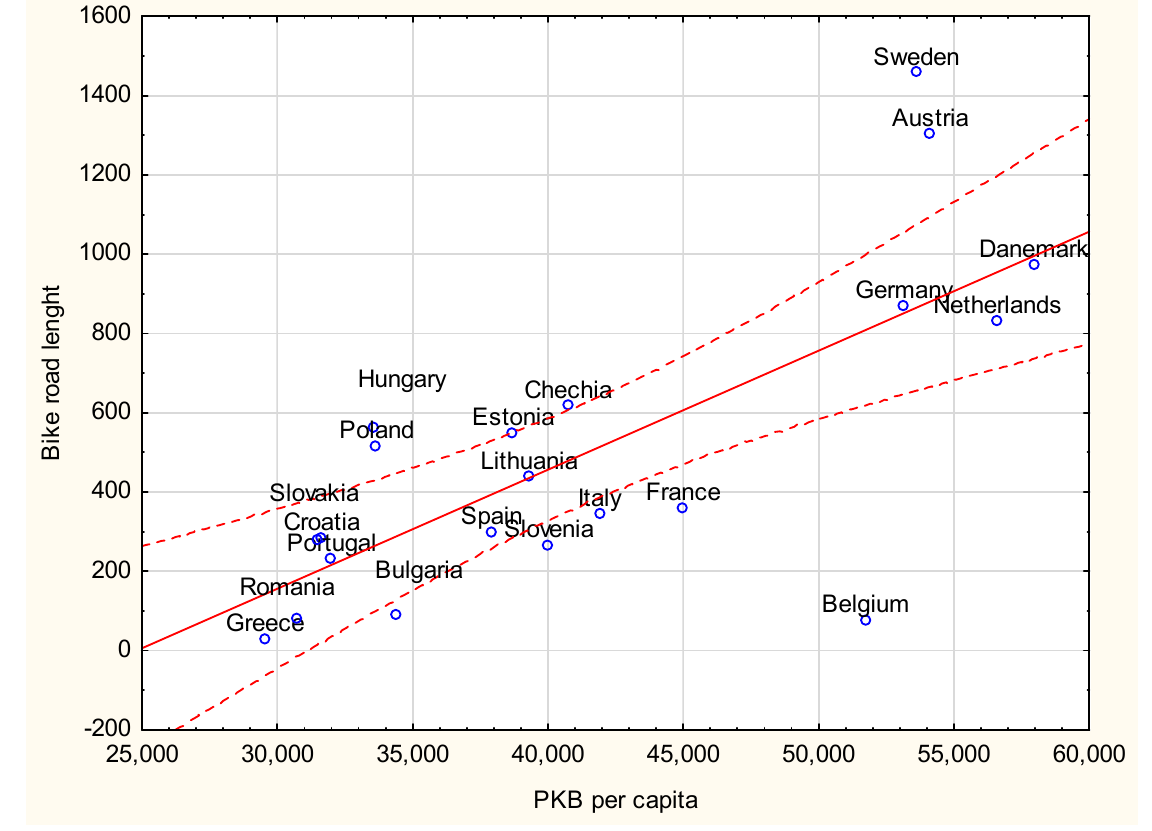
Figure 11. Scatter plot between GDP per capita and average bicycle road length in the smart cities of 17 countries. Source: author’s analysis.